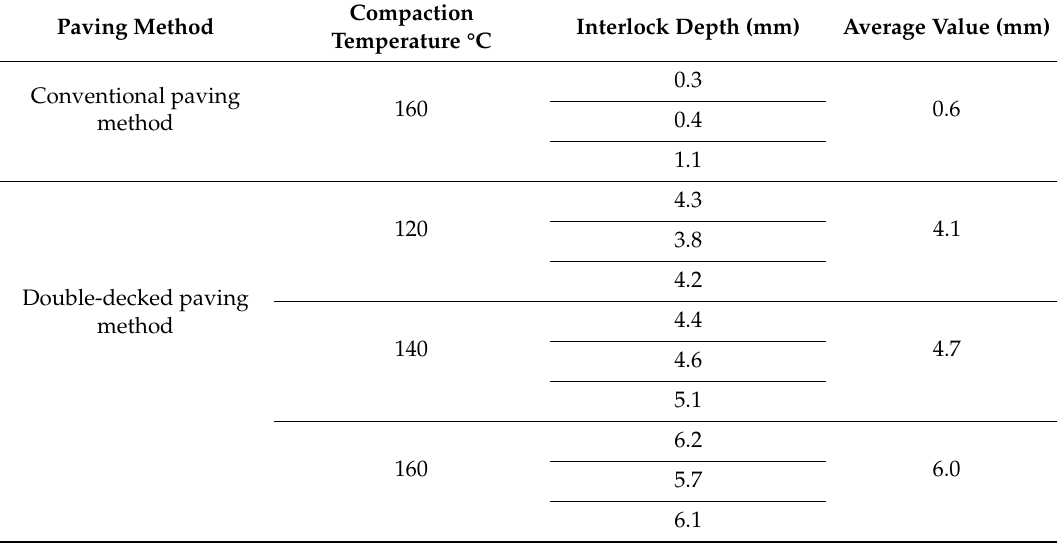
Table 4. Experimental result for the interlocking depth of the upper and lower layers of asphalt mixture under conventional and double-decked paving